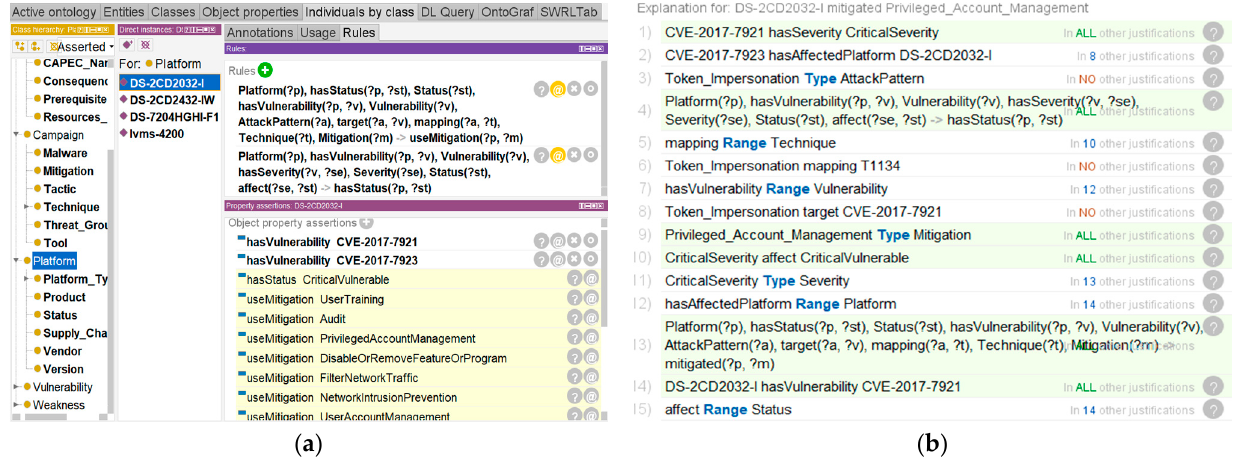
Figure 9. Reasoning mitigation.